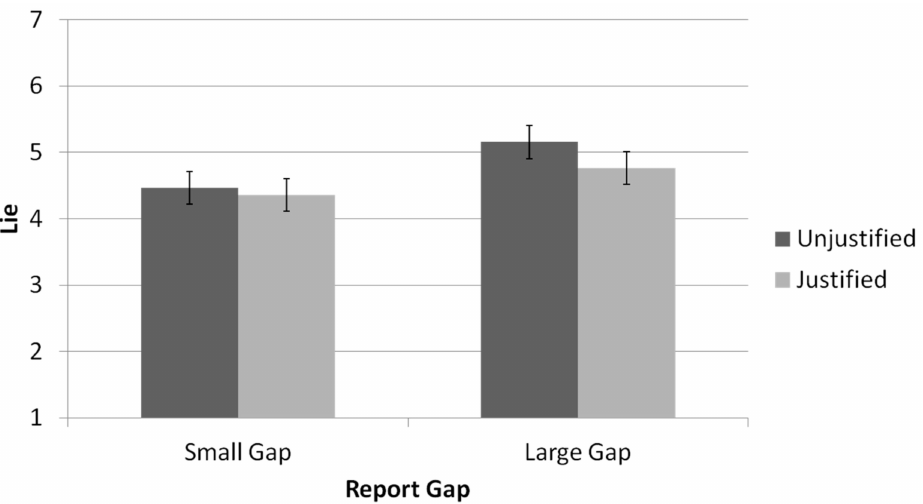
Figure 3. Perceived lie as a function of the gap between real and reported outcome and available justification (Results are across the both interaction partner conditions. Error bars are +1 SE around the